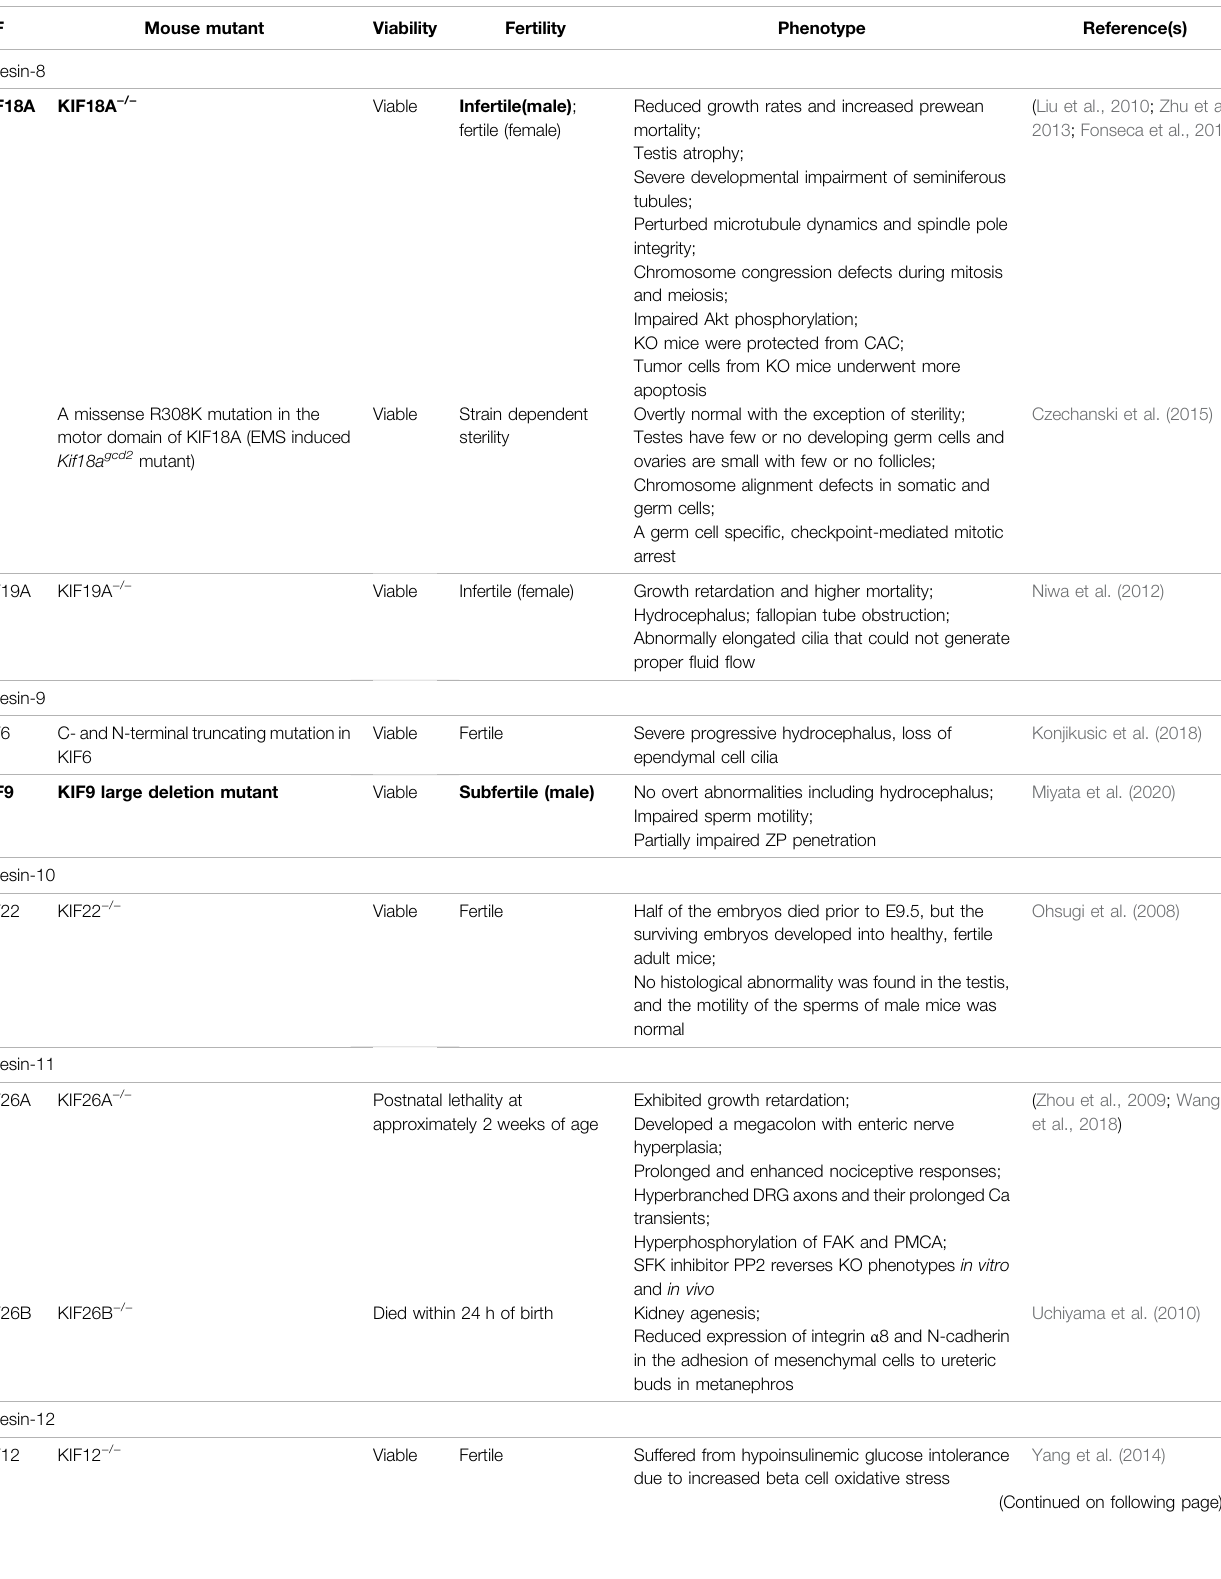
TABLE 2 | ( Continued ) Phenotypes in KIF mutant mice/embryos a